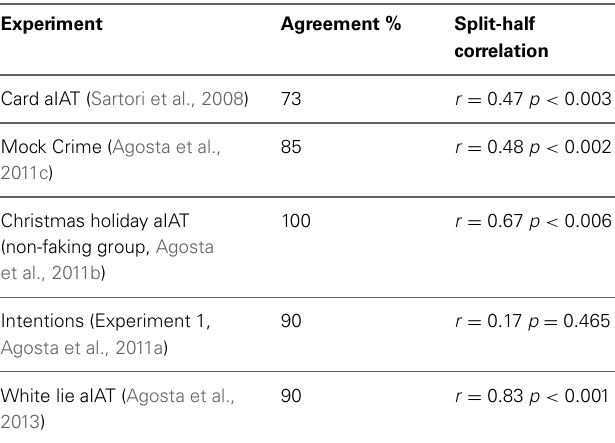
Table 2 | Split-half correlation, percentage agreement between classifications derived on even numbers and classification derived from odd numbers in five